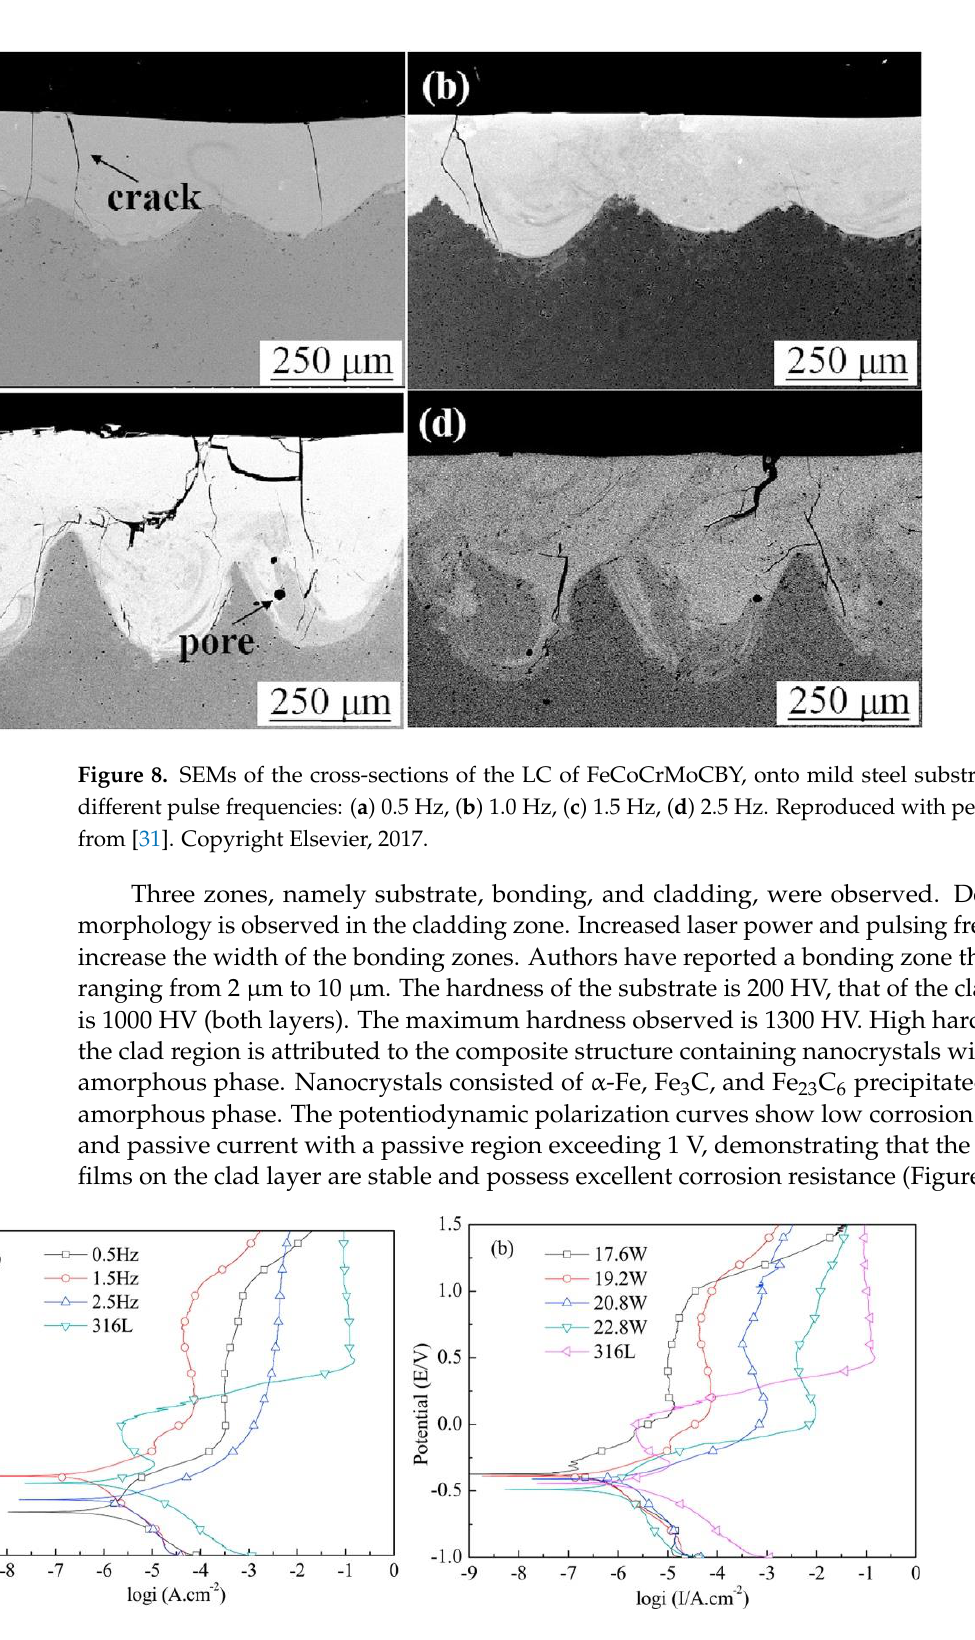
Figure 9. Potentiodynamic polarization curves LC of FeCoCrMoCBY, onto mild steel substrate: ( a ) different pulse frequencies and ( b ) different laser powers. Reproduced with permission from [31]. Copyright Elsevier,